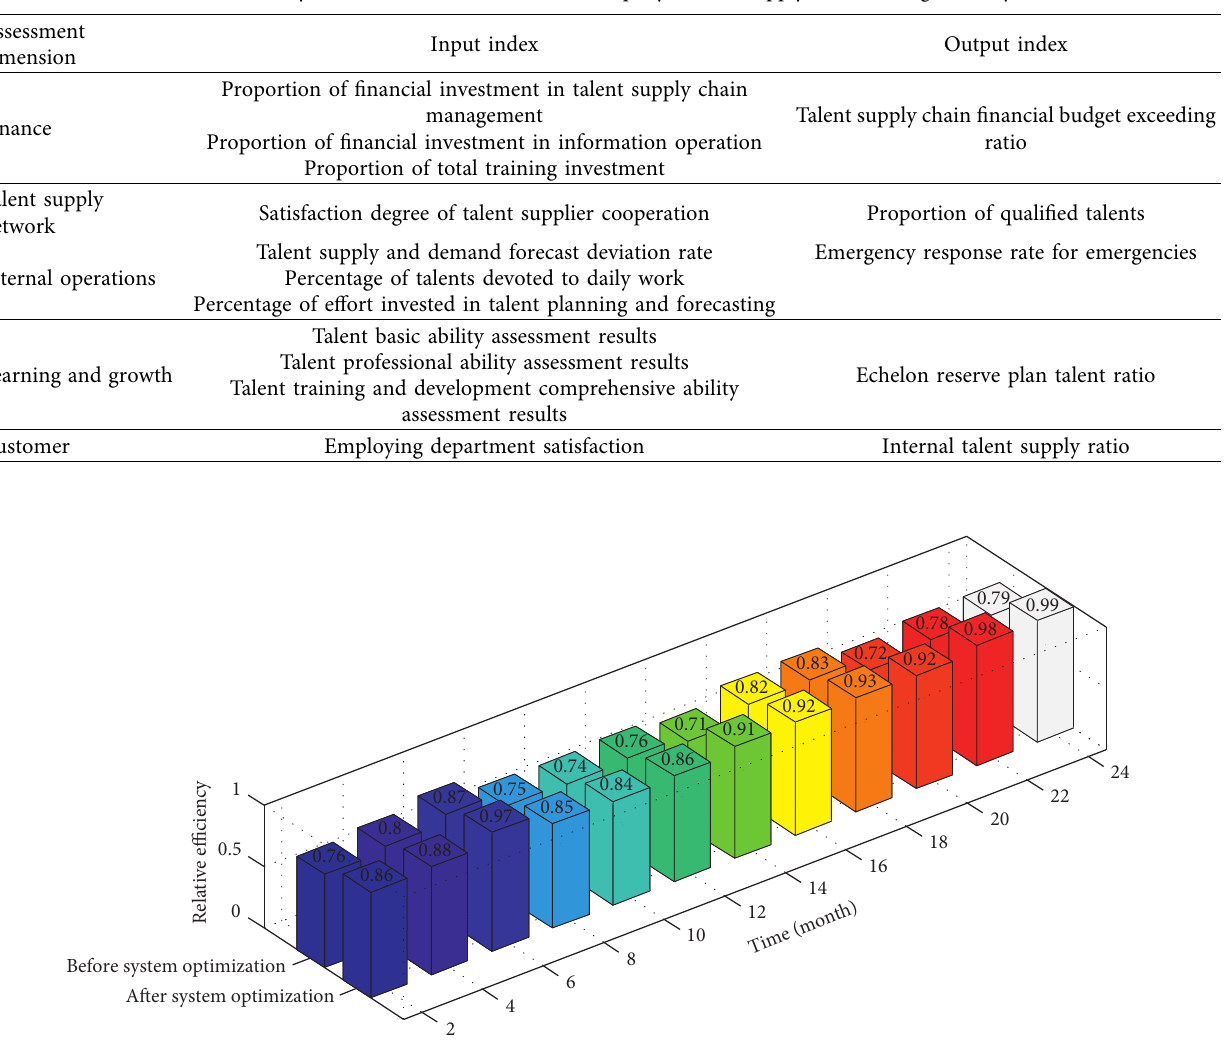
Figure 6: Systematic integration and distribution of enterprise HR work. Table 1: Summary of evaluation indicators of a company’s talent supply chain management system.